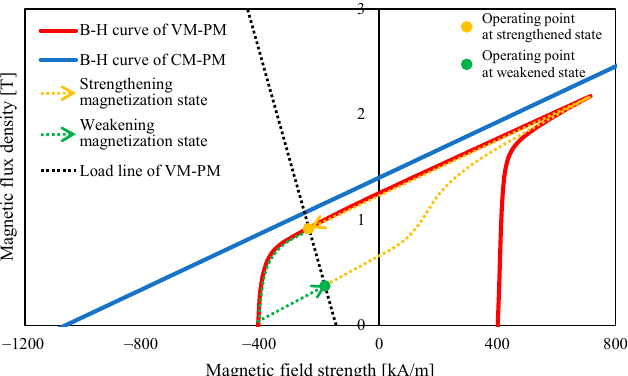
Figure 3. Schematic diagram of B-H curves of CM- and variably magnetizable-permanent magnets (VM-PM), and magnetization manipulation of VM-PM. ©2020 IEEE. Reprinted with permission, from K. Otsuka, T. Okada, T. Mifune, H. Matsumori, T. Kosaka and N. Matsui, Proceeding of 2020 IEEE Energy Conversion Congress and Exposition (ECCE), IEEE, 2020.